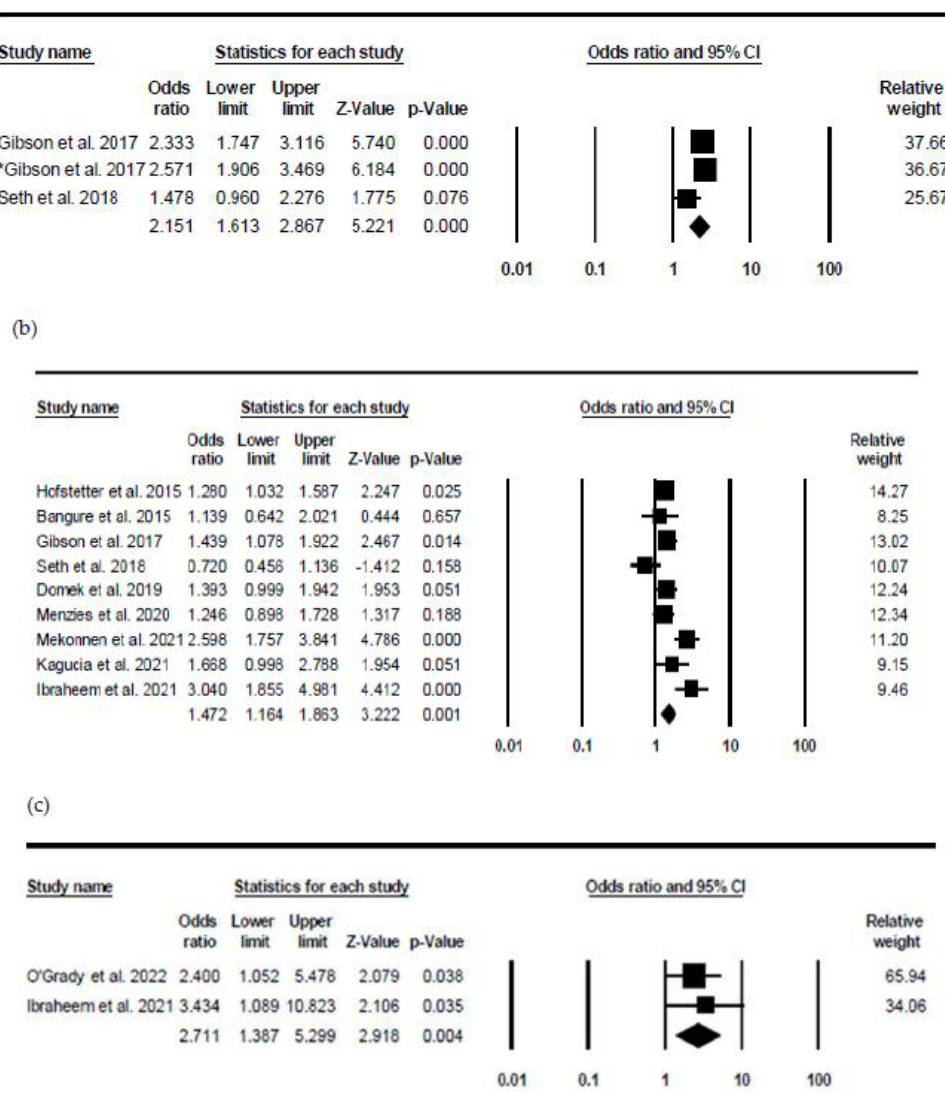
Figure 3. Forest plot of interventions on timeliness. ( a ) SMS reminder and incentive on timeliness. Heterogeneity: Q-value = 4.453, p = 0.108, I-square 55.089. [31,32]. ( b ) SMS reminder. Heterogeneity: Q-value = 29.290, p = 0.001, I-square = 72.687. [9,29,31,32,34,35,38,42,44] ( c ) SMS health education on timeliness. Heterogeneity: Q-value = 0.246, p = 0.620, I-square = 0.000. [33,44].